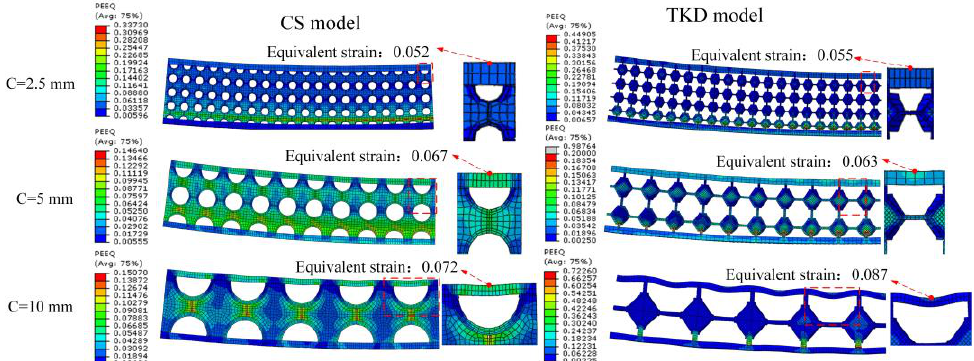
Figure 14. Equivalent strain of spherical AFSP with different core cell sizes.